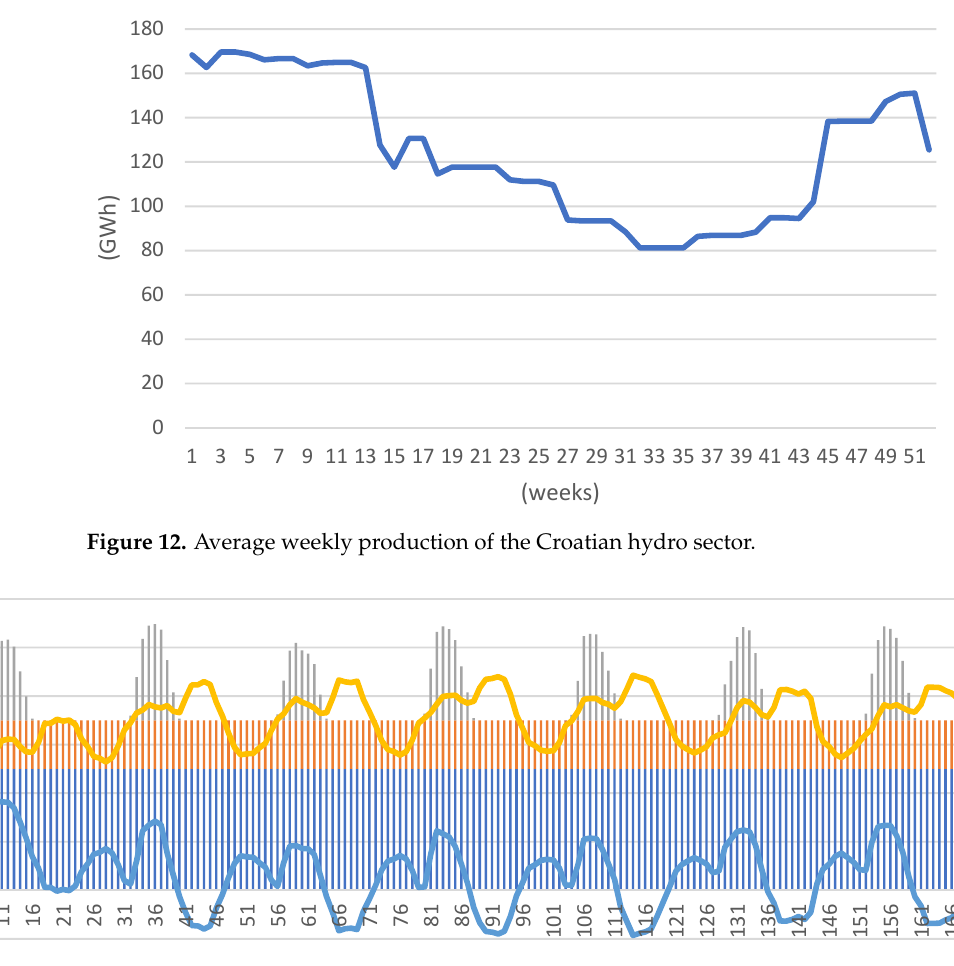
Figure 11. Solar power plant utilisation.